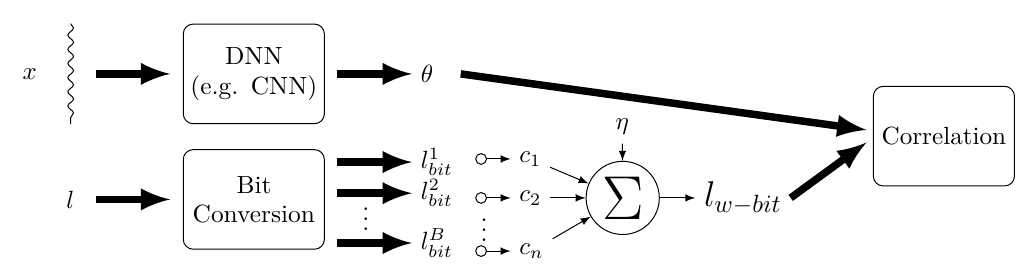
Figure 5: Correlation optimization using a small MLP to approximate the bitwise weighting coefficients for the leakage l , while the power traces x are encoded by a DNN. During training, the correlation loss according to (22) is used to update the weights of both networks in